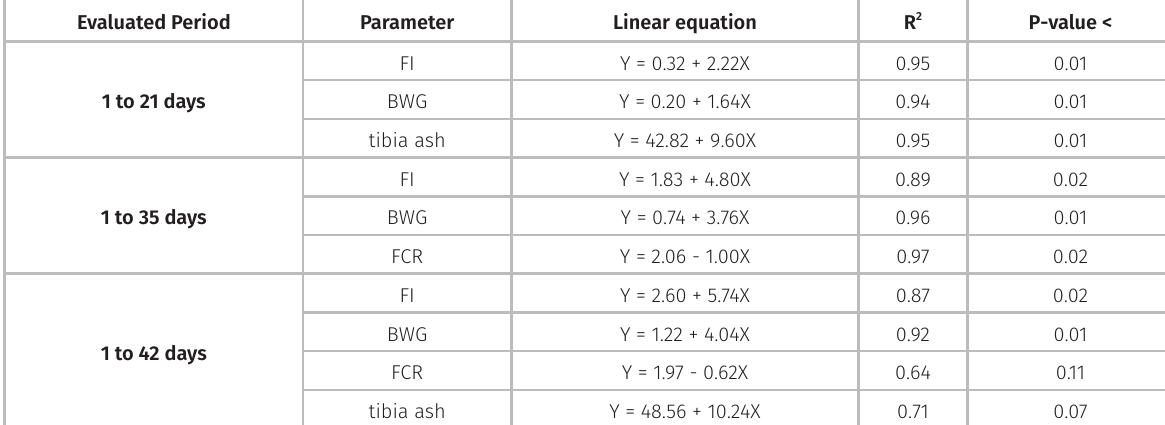
Table IV. Linear equations obtained for feed intake (FI), body weight gain (BWG), feed conversion ratio (FCR) and tibia ash of broilers fed increasing non-phytate phosphorus levels in the age periods from 1 to 21, 1 to 35 and 1 to 42 days 1 .